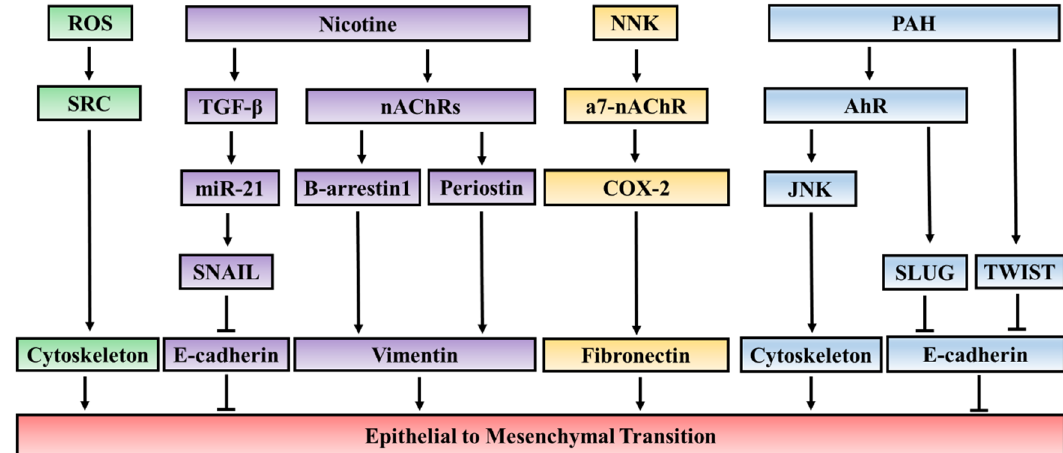
Figure 1. Overview of the molecular networks by which different compounds in cigarette smoke regulate EMT. Reactive oxygen species (ROS) found in cigarette smoke can activate SRC resulting in cytoskeletal modification. Nicotine can induce EMT through nAChRs-dependent and nAChRs-independent pathways. In the nAChRs-dependent pathway, the activation of nAChRs results in the recruitment of β -arrestin1 on to the promoters and promotes the expression of mesenchymal markers. Additionally, the activation of nAChRs also induces the expression of periostin, the overexpression of which has been reported to cause EMT. In the nAChRs-independent pathway, nicotine can induce EMT through upregulating miR-21 in a manner dependent on TGF- β signaling. Nicotine-derived nitrosamine ketone (NNK) has been found to upregulate the expression of the mesenchymal marker fibronectin through cyclooxygenase-2 (COX-2), which is mediated by the activation of a7-nAChR. Polycyclic aromatic hydrocarbons (PAH) can mediate EMT through the activation of aryl hydrocarbon receptor (aryl hydrocarbon receptor), which triggers a marked cytoskeleton remodeling associated with the activation of the JUN N -terminal kinase (JNK) pathway. Increased nuclear accumulation of AhR in response to PAH also leads to transcriptional activation of